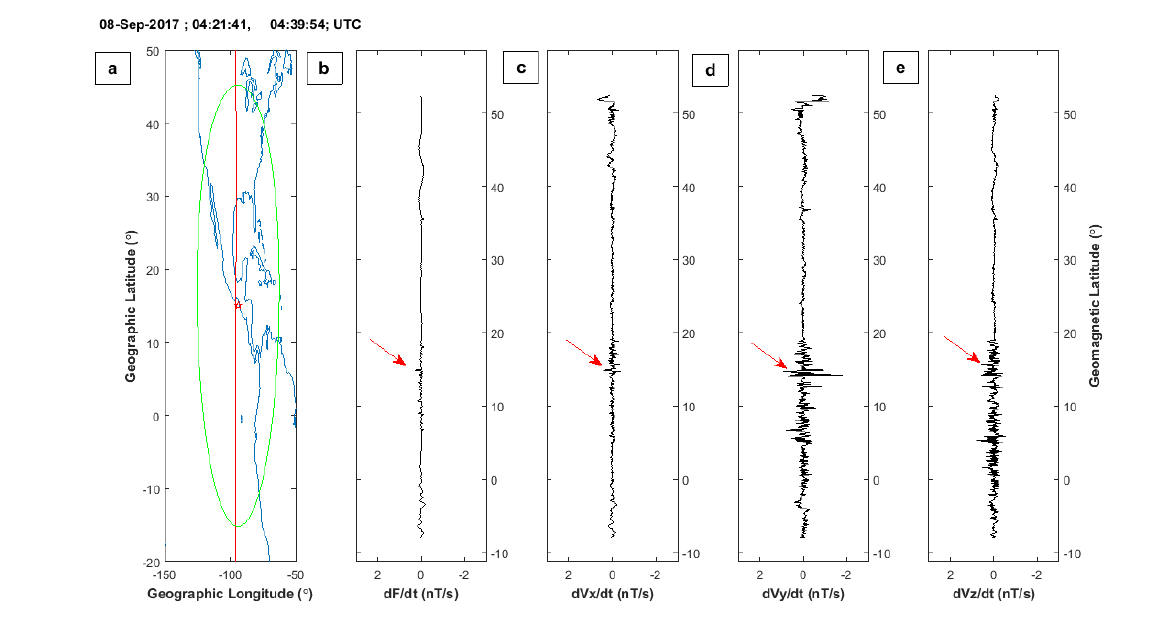
Fig. 4. Results of Swarm A track analysis for the Mexico earthquake (08 September 2017) on earthquake day. (a) The earthquake epicenter, the track and Dobrovolsky’s area are shown as a red asterisk, a red line and a green circle, respectively. The track passed the Dobrovolsky’s area between the 04:21:41 and 04:39:54UTC. The horizontal and vertical axes represent the geographic longitude and latitude. (b), (c), (d) and (e) The differences between the time-series of the derivatives of the measured magnetic fields scalar and vectors (X, Y, Z) values, respectively, and a fitted polynomial of 12 degree along this track. The vertical axis represents